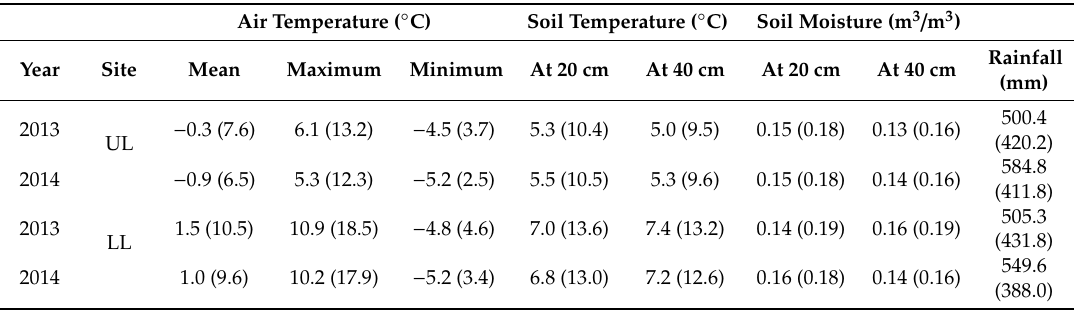
Table 1. Annual climate records at UL and LL during 2013 and 2014. Values in parentheses are related to the growing season